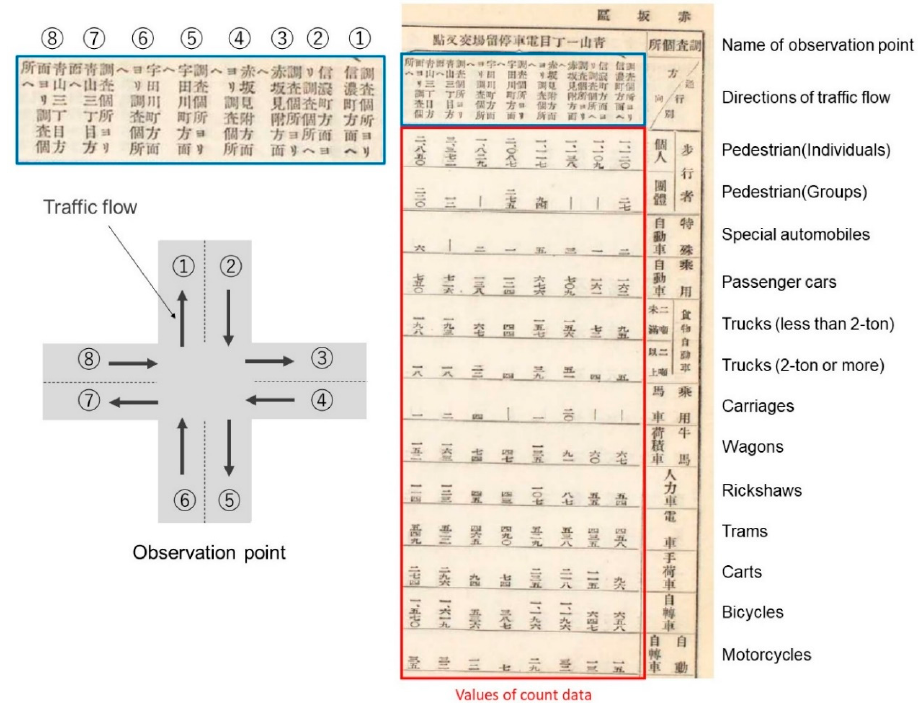
Figure 2. A part of traffic census table “Tokyo-shi Kotsu-chosa Tokei-hyo (Traffic census in Tokyo City)” and an example of an observation point. and an example of an observation